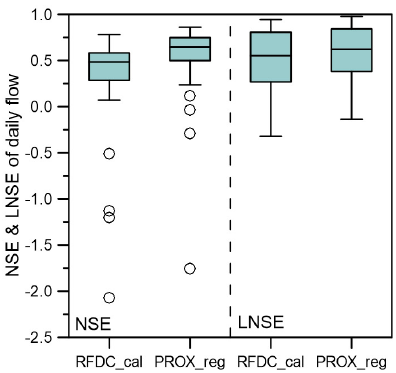
Figure 5. Box plots of NSE and LNSE values between the observed and the predicted hydrographs by RFDC_cal and PROX_reg for the 45 catchments under the cross-validation